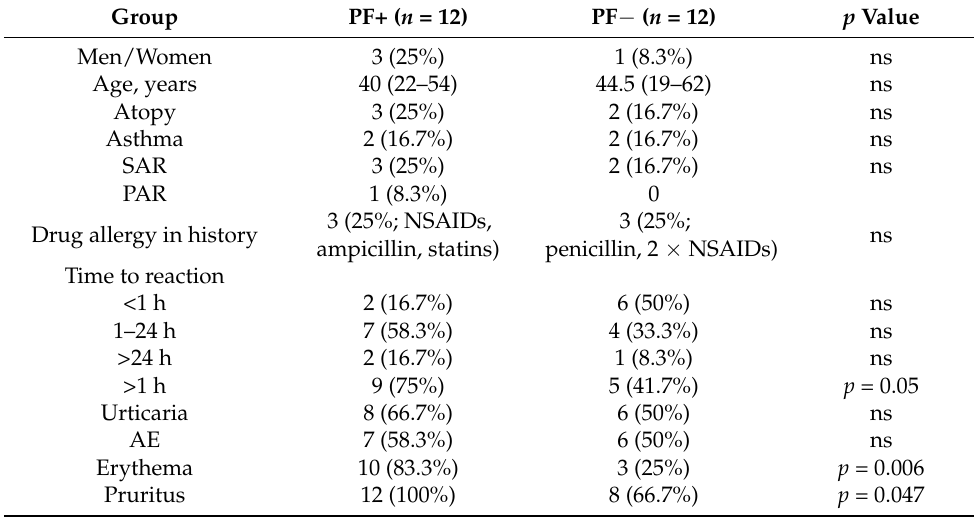
Table 1. Patients’ clinical